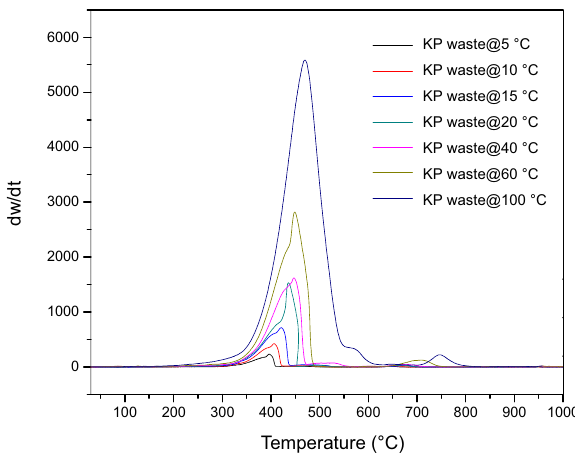
Figure 4. Derivative thermogravimetry plot (derivative weight vs. temperature) of keyboard plastic waste at 5, 10, 15, 20, 40, 60 and 100 °C/min heating rates